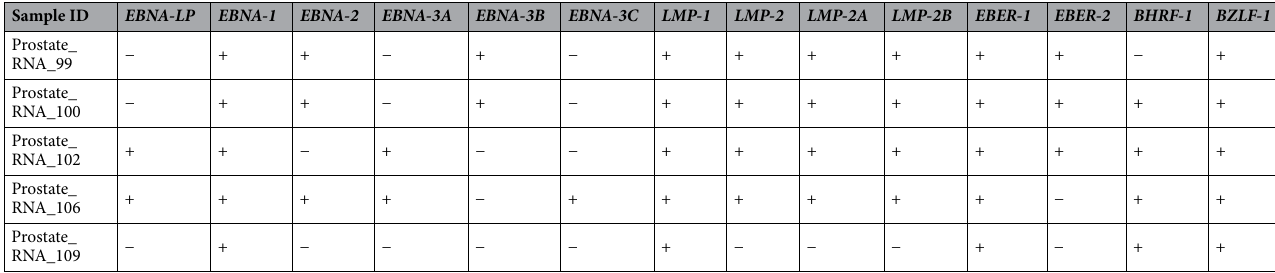
Table 3. Characterization of EBV latency profile in EBV-positive prostate carcinoma tissues. The latency profile was mapped based on the expression of the following latency-associated genes: EBNA-3B, EBNA-3A,